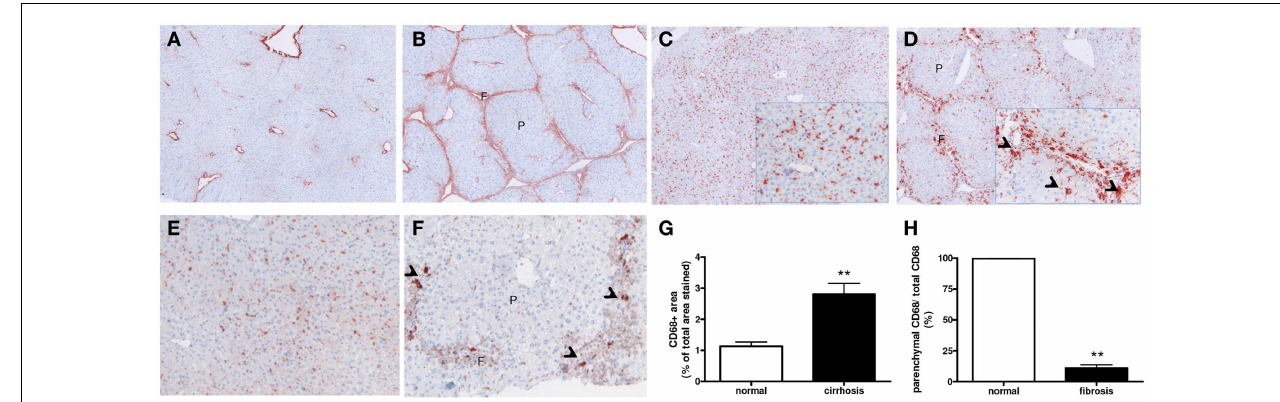
[arrow heads in insert (C,F) ]. (G,H) Image analysis of CD68 staining. While the total area of CD68 + cells was increased in fibrotic livers, a significantly lower CD68-stained area was found in the parenchyma (p) of fibrotic livers as compared to normal. Magnifications: 40 × (A–D) , 100 × (E,F) , and 200 × ( inserts ). f, Fibrotic matrix; p , liver parenchyma. N = 6/group. ** p <